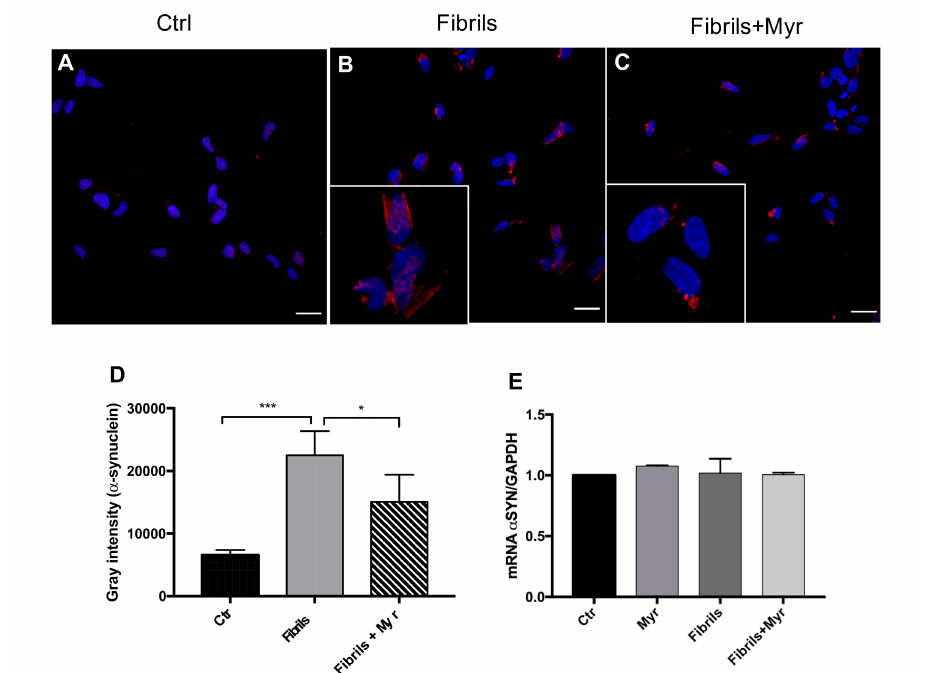
Figure 1. Myr reduces α -syn in SH-SY5Y cells. ( A – C ) SH-SY5Y cells were pretreated with or without 50 µ M Myr and then exposed to 0.5 µ M α -syn fibrils for 24 h. Immunofluorescent staining of α -syn (red) and nuclear staining with DAPI (blue) are shown. ( D ) Summary of results demonstrating the mean intensity per cell measured as grayscale intensity. Scale bars represent 20 µ m. ( E ) α -syn gene expression measured by qRT-PCR and represented as fold change compared to control cells (Ctr). All data, derived from three independent experiments, are expressed as mean ± SEM (* p < 0.05; *** p < 0.001); one-way ANOVA test followed by Bonferroni correction was used for all